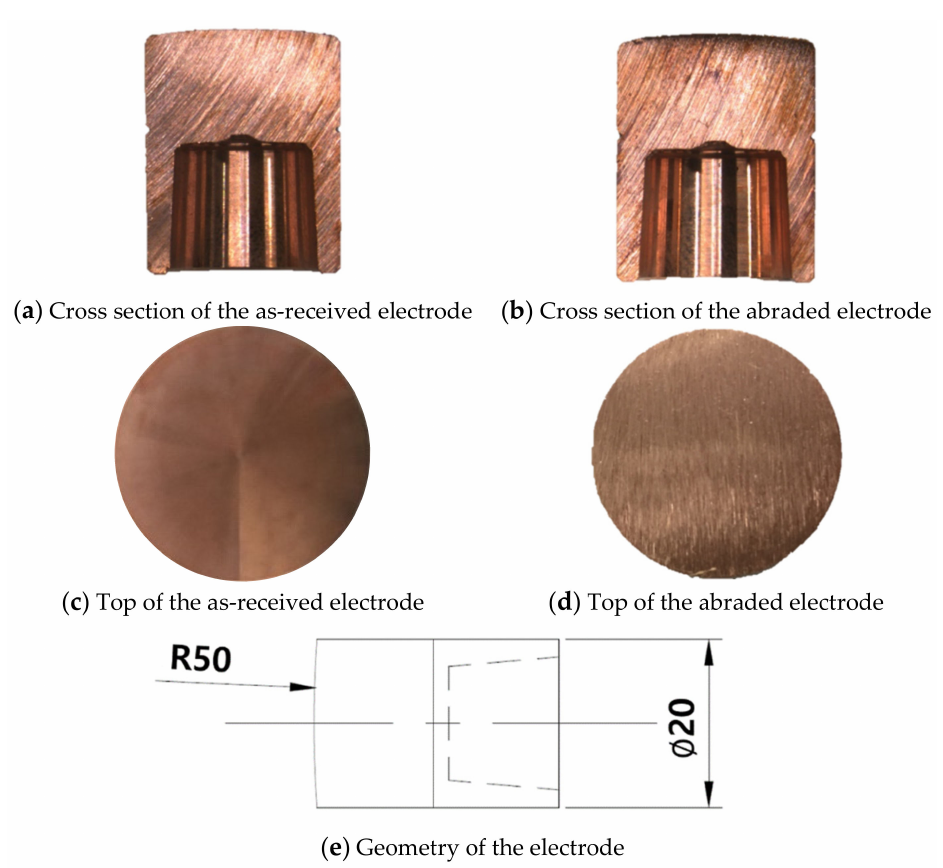
Figure 1. Configuration of the electrodes used in this